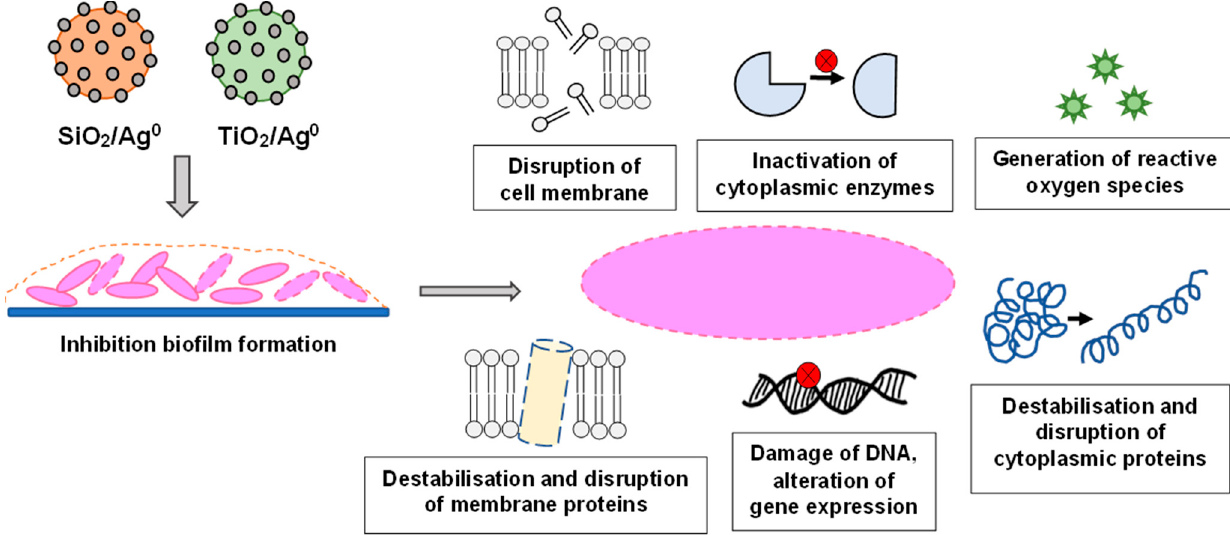
Figure 1. The various antibacterial targets of